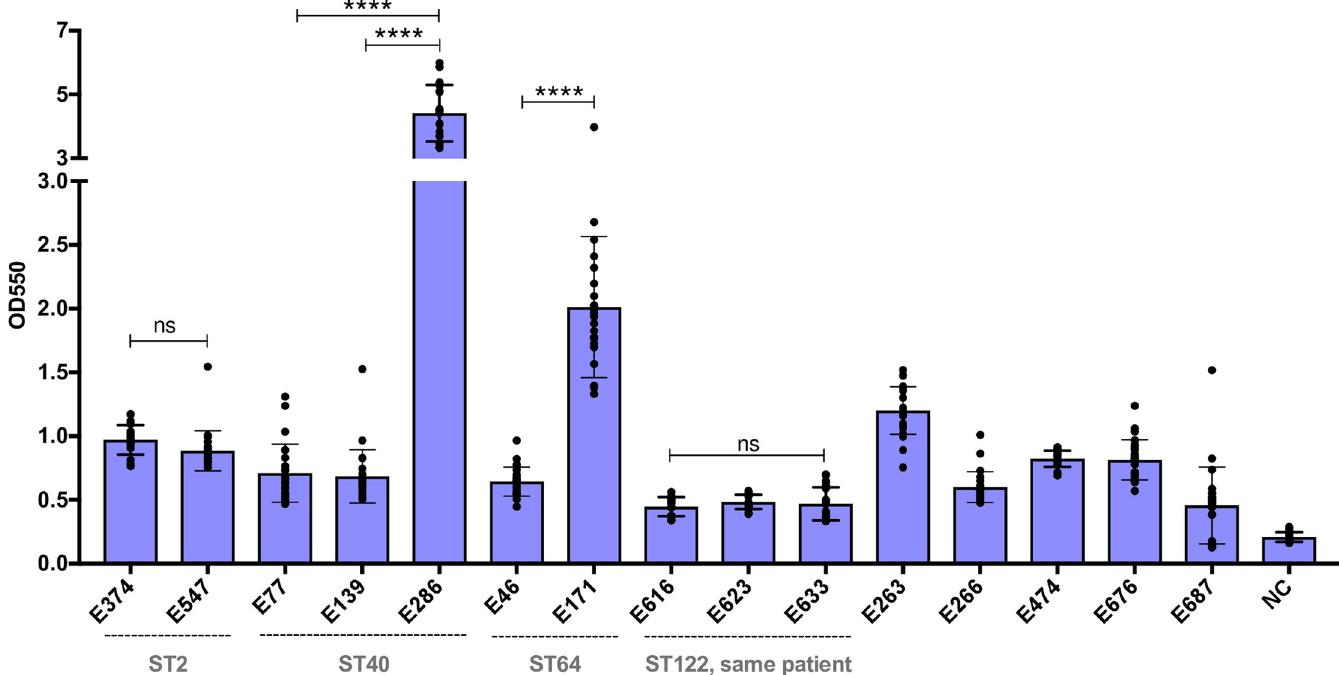
Fig 2. Variable biofilm production among endophthalmitis isolates. In vitro biofilm production of 15 E . faecalis endophthalmitis isolates. Biofilm formation was measured as the optical density (OD) at 550nm using a standard crystal violet-based assay. Isolates are arranged according to their sequence type (ST), and STs with more than one isolate are labeled. Bars shown mean crystal violet absorbance values, and error bars show standard deviation of triplicate experiments, each with eight technical replicates. NC = negative control; ���� P < 0.0001 by two-tailed t test; ns = not significant.